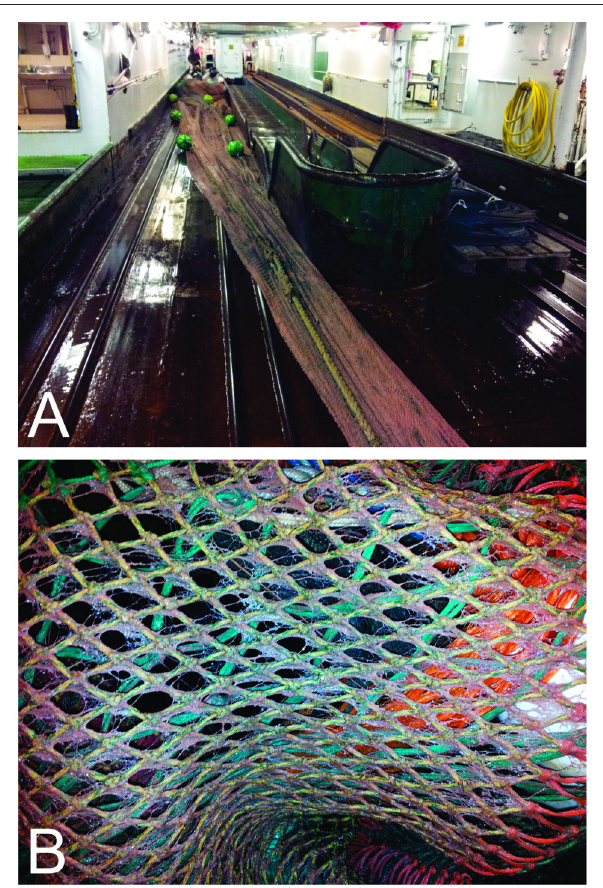
FIGURE 3 | (A) Trawl bag of RV Helmer Hanssen showing the red slime contaminating the trawl bag and (B) Close-up view of the trawl meshes, following one of the Campelen 1800# bottom trawl hauls, st1708 on 7 November 2015 ( Table 2 ).